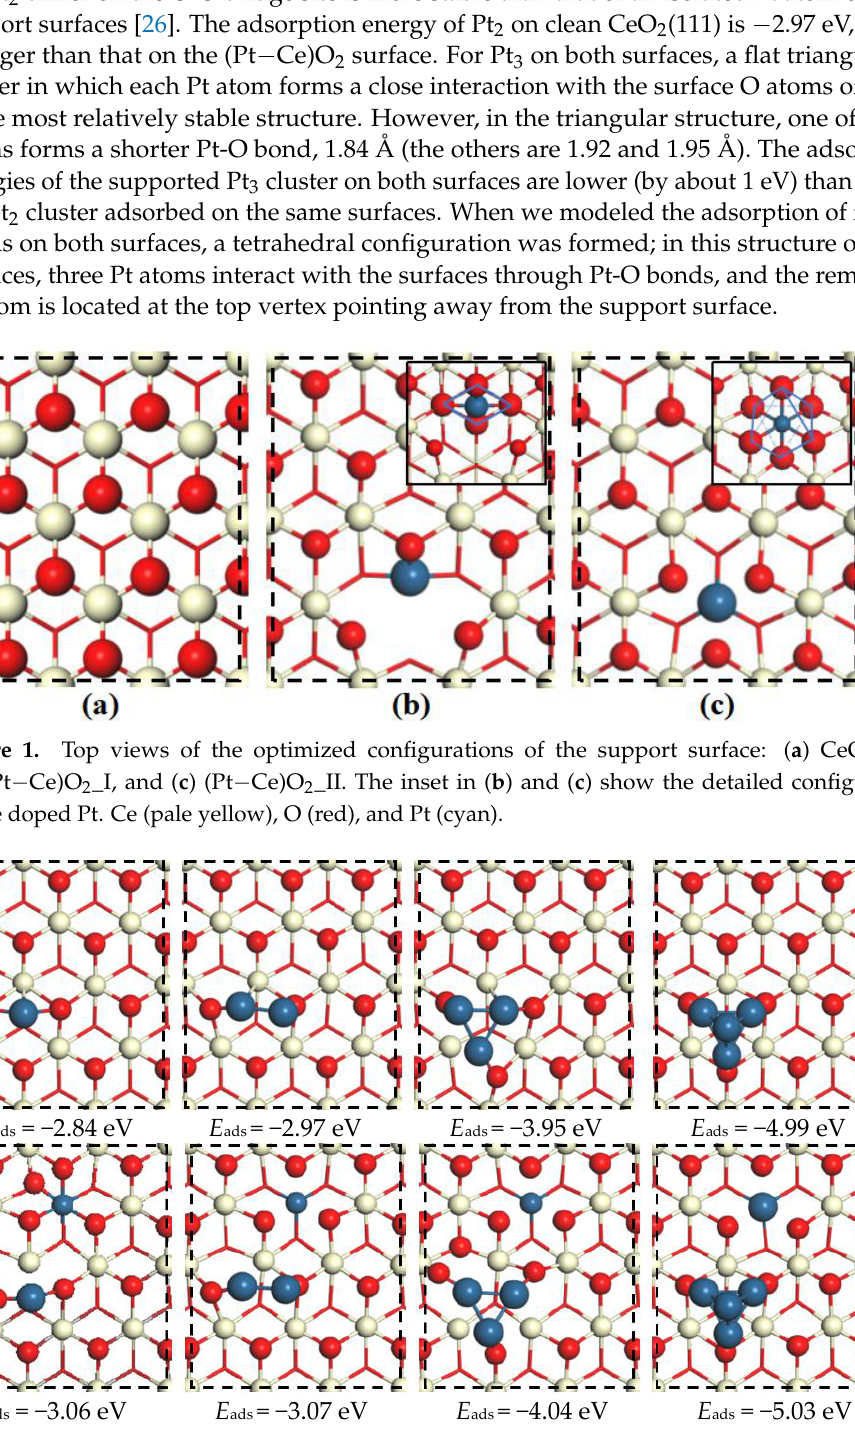
Figure 2. Top views of the optimized configurations of Pt n clusters on the CeO 2 surface (up) and (Pt−Ce)O 2 surface (down). (Pt − Ce)O 2 surface